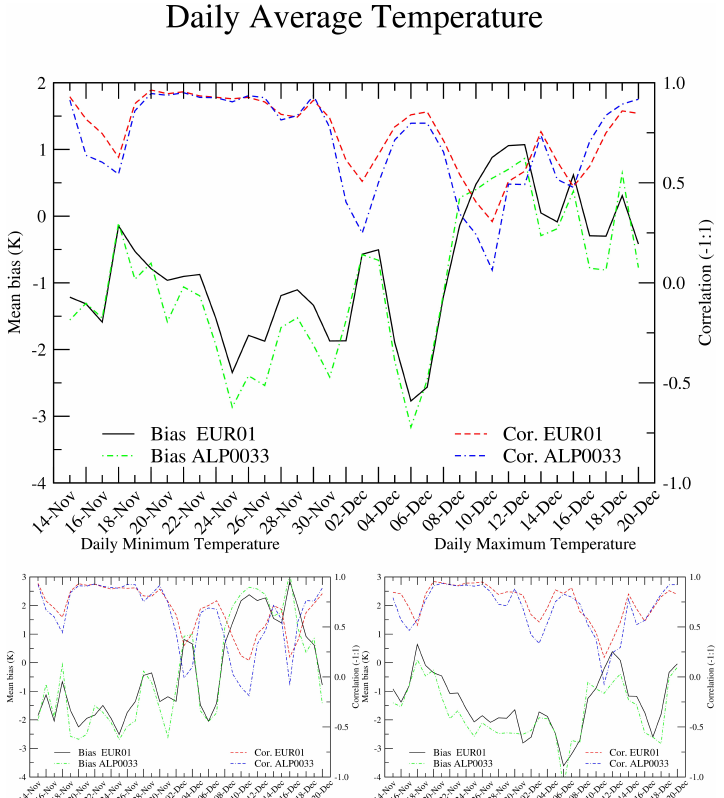
Figure 2. Evolution of spatial error statistics (spatial average) of the daily mean 2 m temperature ( top ), the daily min 2 m temperature ( bottom left ) and the daily max 2 m temperature ( bottom right ) for EUR01 and ALP0033 domains during the period of interest by the use of the E-OBS